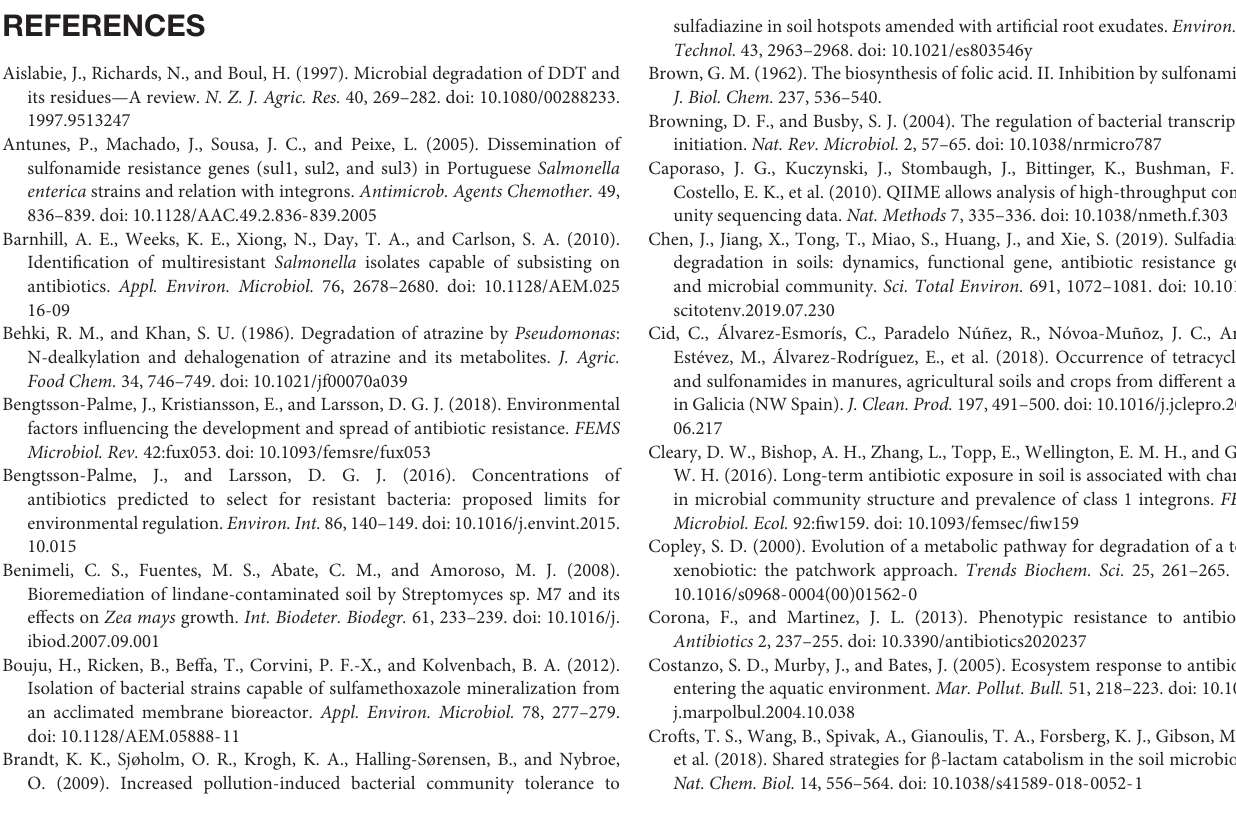
Microbacterium sp. C448 (C448). Supplementary Table 5 | Initial abundance and phylogeny (phylum, class, order) of the seven OTUs highly likely to come from manure in the four soils and in the